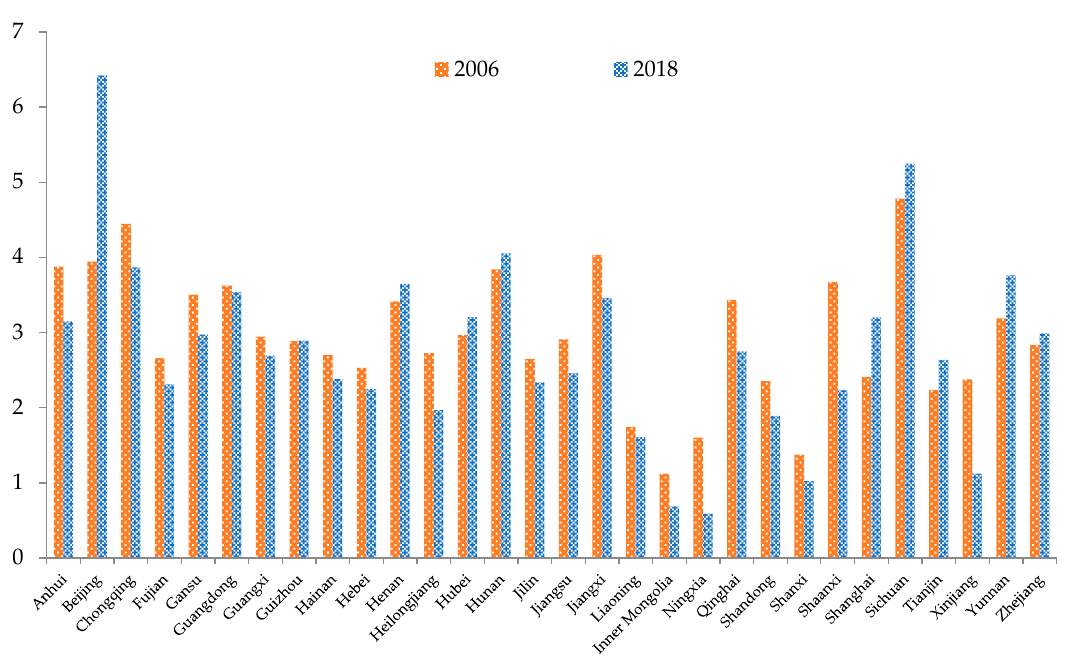
Figure 3. Comparison of the spatial distribution of EWP in China: 2006 and